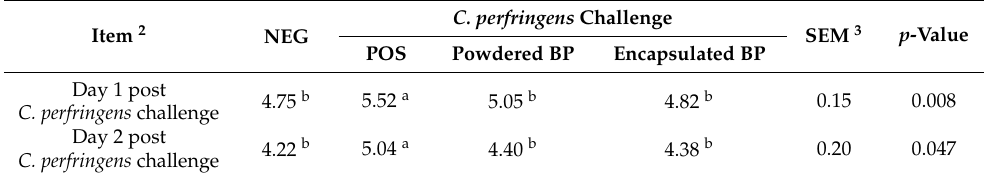
Table 3. Effects of dietary encapsulated and powder BPs on cecal C. perfringens counts (log 10 cfu/g digesta) in broiler chicken challenged with C. perfringens 1